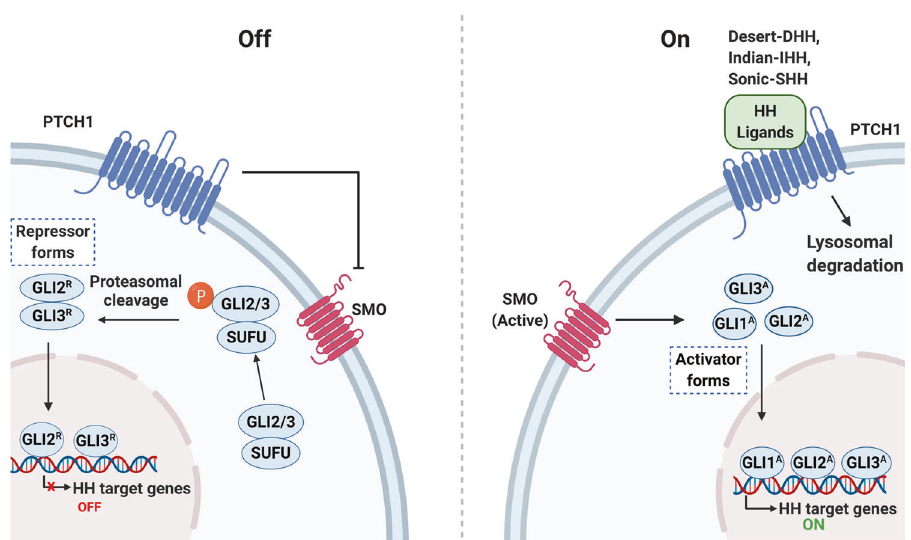
Fig. 5 Canonical SMO-dependent hedgehog (HH) signaling pathway. Unliganded PTCH1 prevents the ciliary translocation of SMO effector protein. GLI2 and GLI3 proteins are sequestered in the cytoplasm by SUFU and phosphorylated by protein kinases, thereby preventing HH target-gene transcription. HH ligands binding triggers endocytic internalization of PTCH1, which results in the accumulation and activation of SMO. Active SMO relieves SUFU-mediated inhibition of GLI2 and GLI3. Activator forms of GLI (GLI1 A /GLI2 A /GLI3 A ) translocate into the nucleus and initiate the transcription of target genes. Figure created with BioRender.com Signal Transduction and Targeted Therapy (2021)